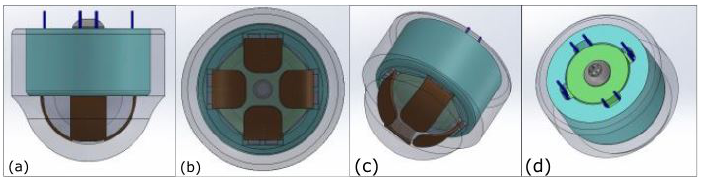
Figure 1. Views of a 3D model of the soft multi-directional force sensor: ( a ) Side, ( b ) front, ( c ) isometric- 1, and ( d ) isometric-2.